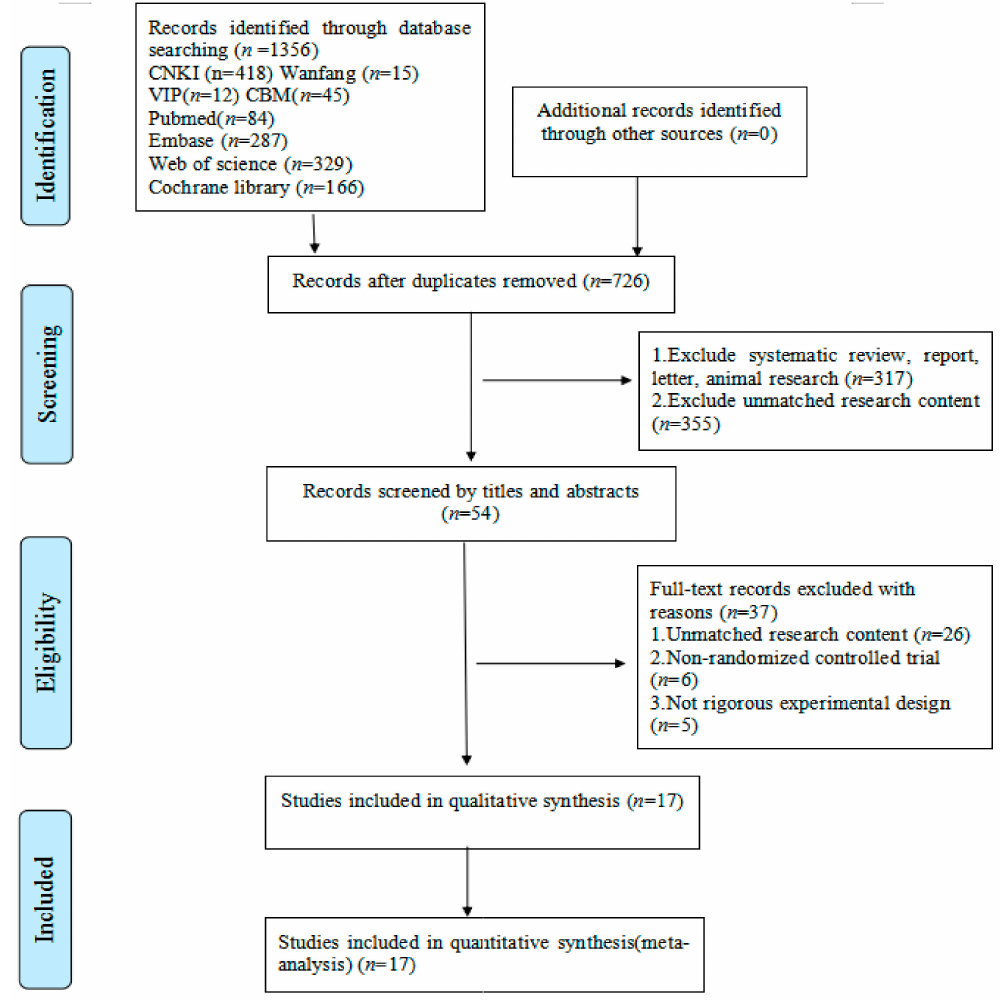
Figure 1. Flow diagram of literature